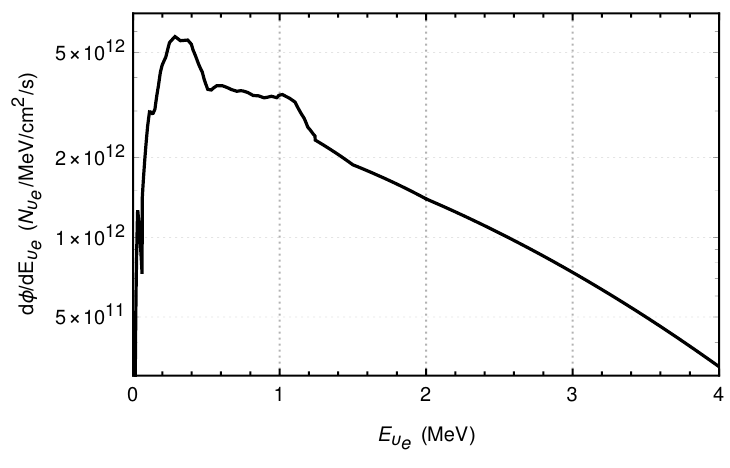
Figure 4 . Antineutrino (cid:13)ux expected at the CONNIE